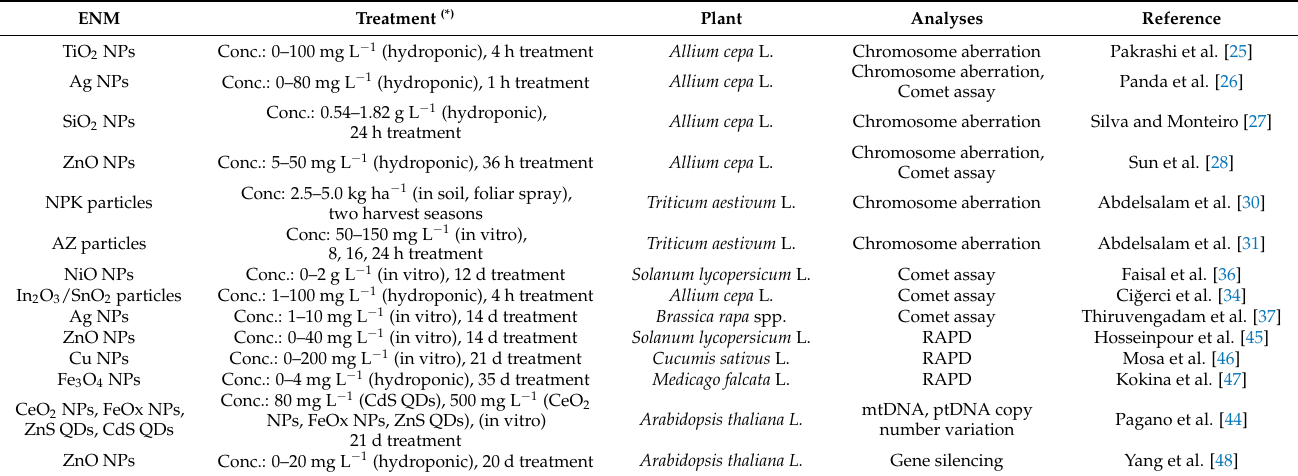
Table 1. Reference list of relevant experiments performed with different tools to identify ENM genotoxic effects in